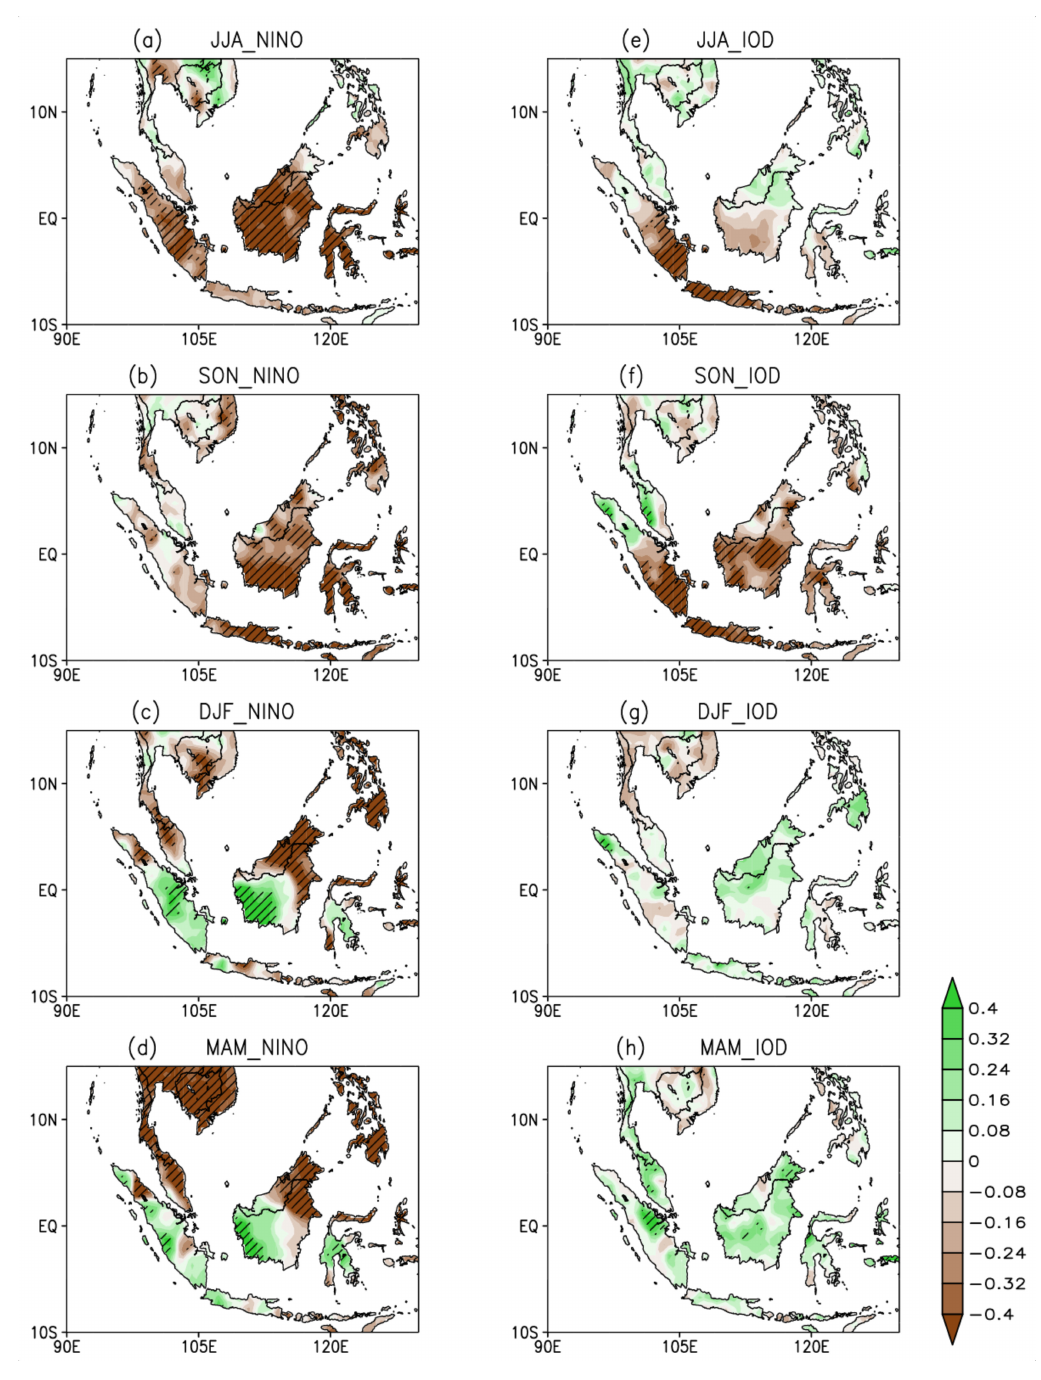
Figure 2. [Left panel] ( a – d ) Partial correlation between the Global Precipitation Climatology Centre (GPCC) rainfall anomalies and Niño3.4 after removing the IOD signal, [Right panel] ( e – h ) partial correlation between the GPCC rainfall anomalies and DMI index after removing the Niño3.4 signal for the season of JJA, SON, DJF, and MAM. The hatched area indicates significance at the 95% level. Unit is mm month − 1